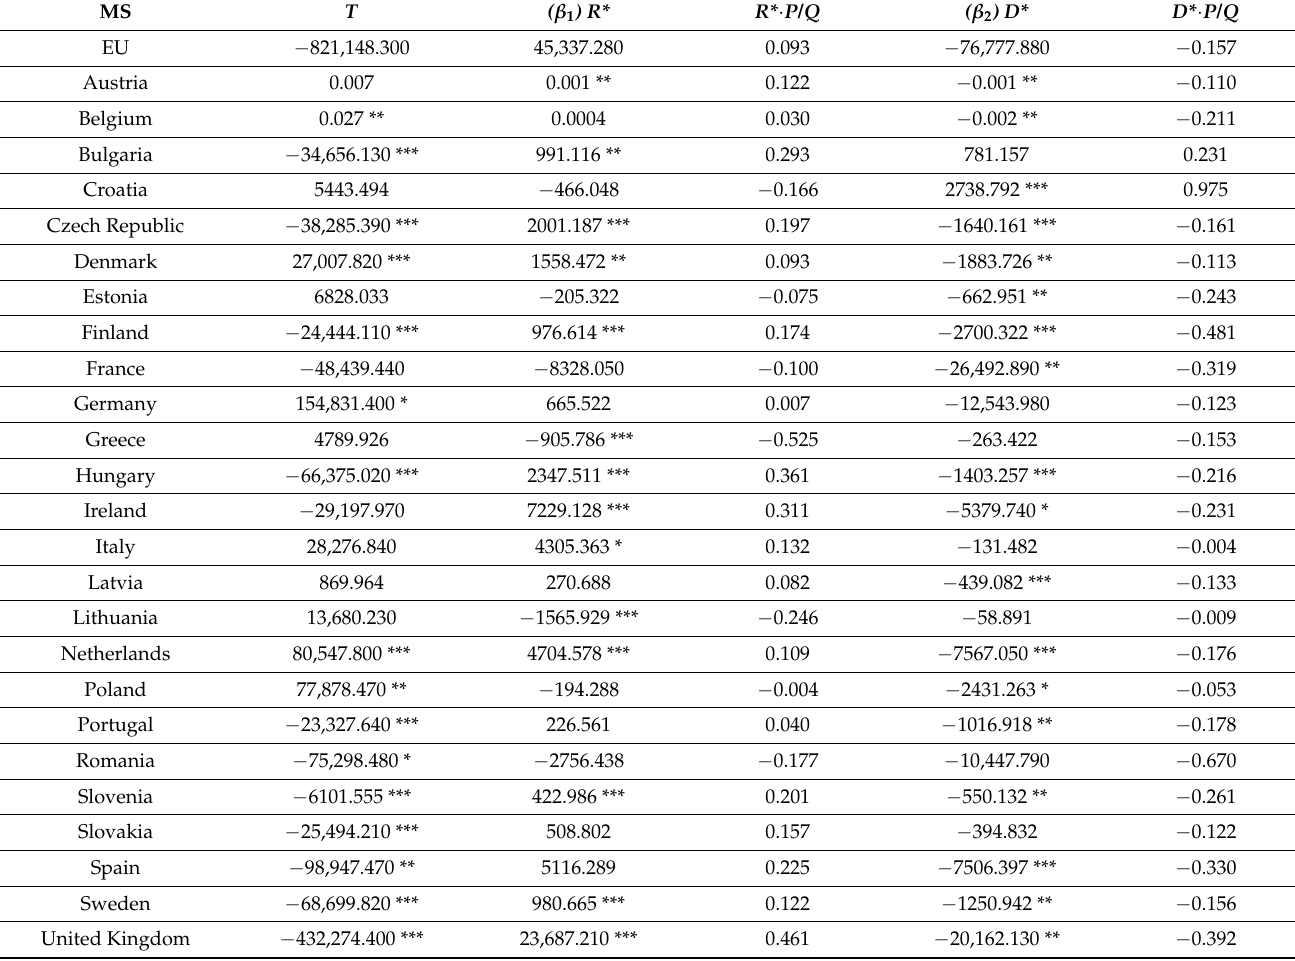
Table 2. Modelling milk supply by means of decompose prices after